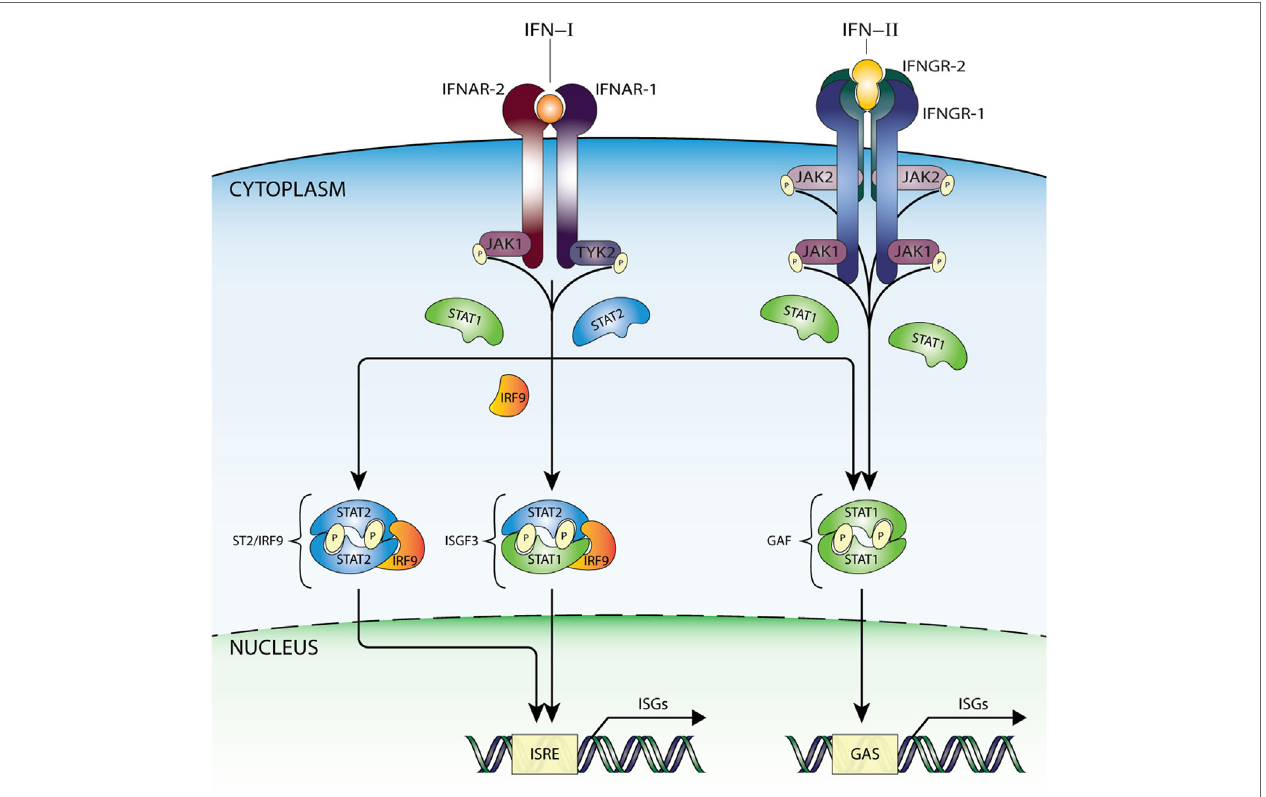
FiGUre 1 | IFN-activated ISG transcription mediated by ISGF3, GAF, and STAT2/IRF9 complexes. IFN-I is recognized by a heterodimeric receptor composed of IFNAR1 and IFNAR2 subunits. After IFN binding and receptor dimerization, juxtapositioning of JAK1 and TYK2 results in increased kinase activity via transphosphorylation and subsequent STAT protein recruitment. Receptor-bound STAT proteins are successively phosphorylated, dimerize, and translocate to nucleus, where ISG transcription is initiated after binding ISRE or GAS sites. Thus, in response to IFN-I three active complexes are formed that play a crucial role in transcriptional regulation. A STAT1/STAT2 heterodimer associated with IRF9, known as ISGF3, binds the ISRE motif present in > 300 ISGs. Second, with the same mode of action, an alternative complex built of STAT2 homodimers and IRF9 (STAT2/IRF9). In addition, STAT1 homodimers (known as GAF), which specifically recognize the GAS sequence. On the other hand, IFN-II interacts with a different receptor built of two IFNGR1 and two IFNGR2 subunits connected with JAK1 and JAK2 kinases, which are capable of phosphorylating only STAT1 proteins, resulting in dimerization and formation of GAF. GAF translocates to the nucleus and targets GAS-containing genes, in a similar way as in response to IFN-I. Abbreviations: IFN, interferon; STAT, signal transducer and activator of transcription; IRF, interferon regulatory factor; JAK, Janus kinase; TYK, tyrosine kinase; ISGF3, interferon-stimulated gene factor 3; GAF, γ -activated factor; ISRE, interferon-stimulated response element; GAS, γ -activated sequence; ISG, interferon-stimulated gene; P, phosphate; IFNAR, IFN α